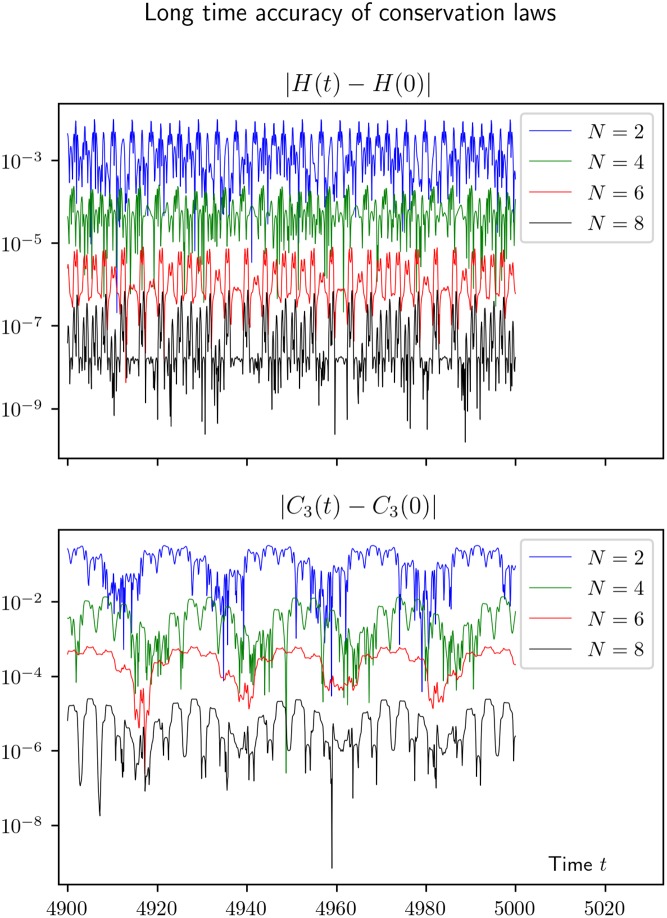
Long time energy error for solutions of a Toda lattice model computed by the KiMoKi solvers.An orbit z(t) with initial value z0 = (0.1, 0, 0.1, 1.40709), corrsponding to H0 = 1 and C3⊥ = −6.45412. The solution is computed for times 0 ≤ t ≤ 5 000 with timestep τ = 0.1; for better visibility only the last hundred time units are plotted.